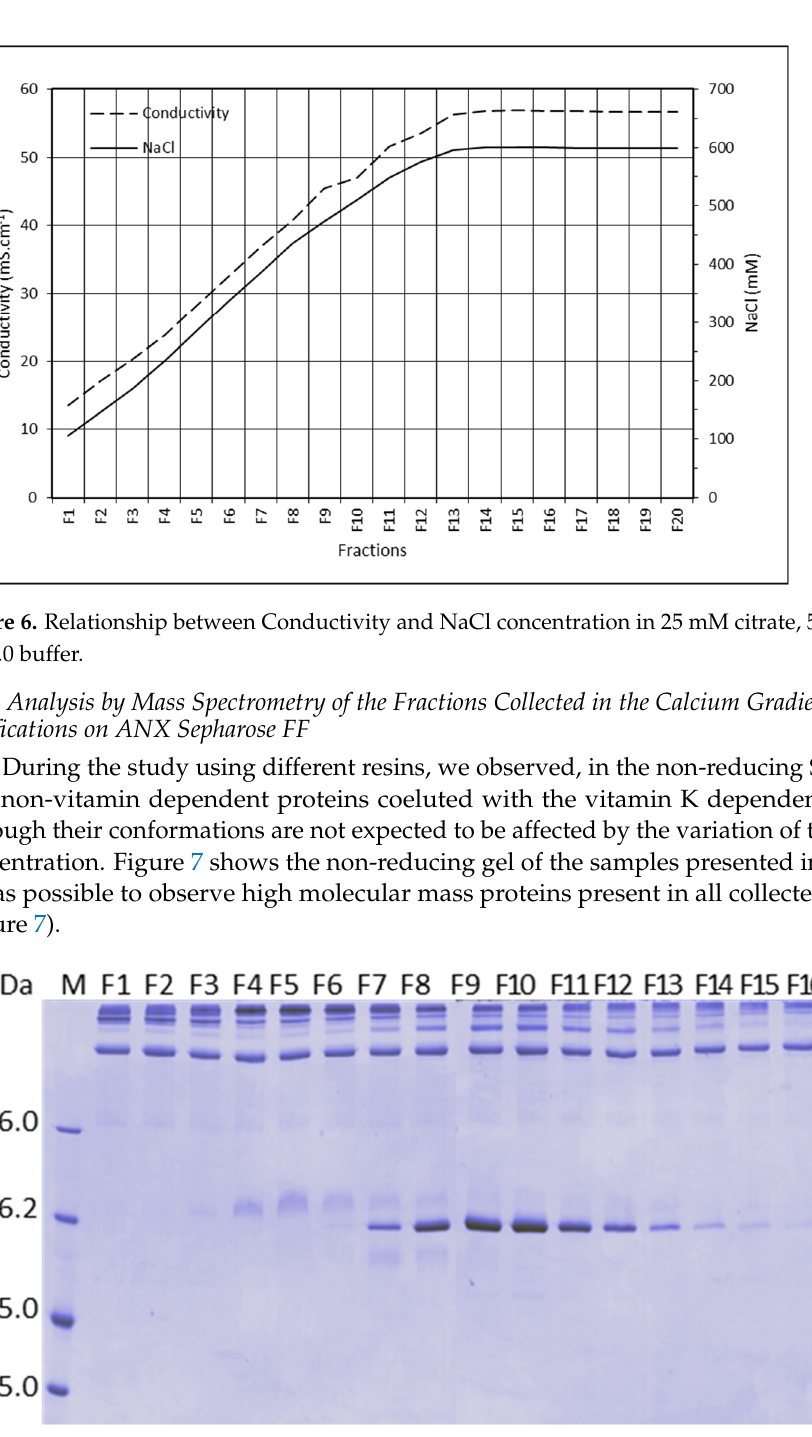
Figure 8. SDS ‐ PAGE 7.5% ( a ) and 5% to 15% ( b ) analysis under reducing conditions of purification of plasma on ANX Sepharose FF with 5 to 25 mM linear CaCl 2 gradient using citrate buffer. Bands marked with an arrow were analyzed by mass spectrometry. The identified proteins were: [A] Com ‐ plement C4b Binding Protein (C4bBP); [B] Fibrinogen; [C] Complement C4; and [D] Prothrombin (FII).